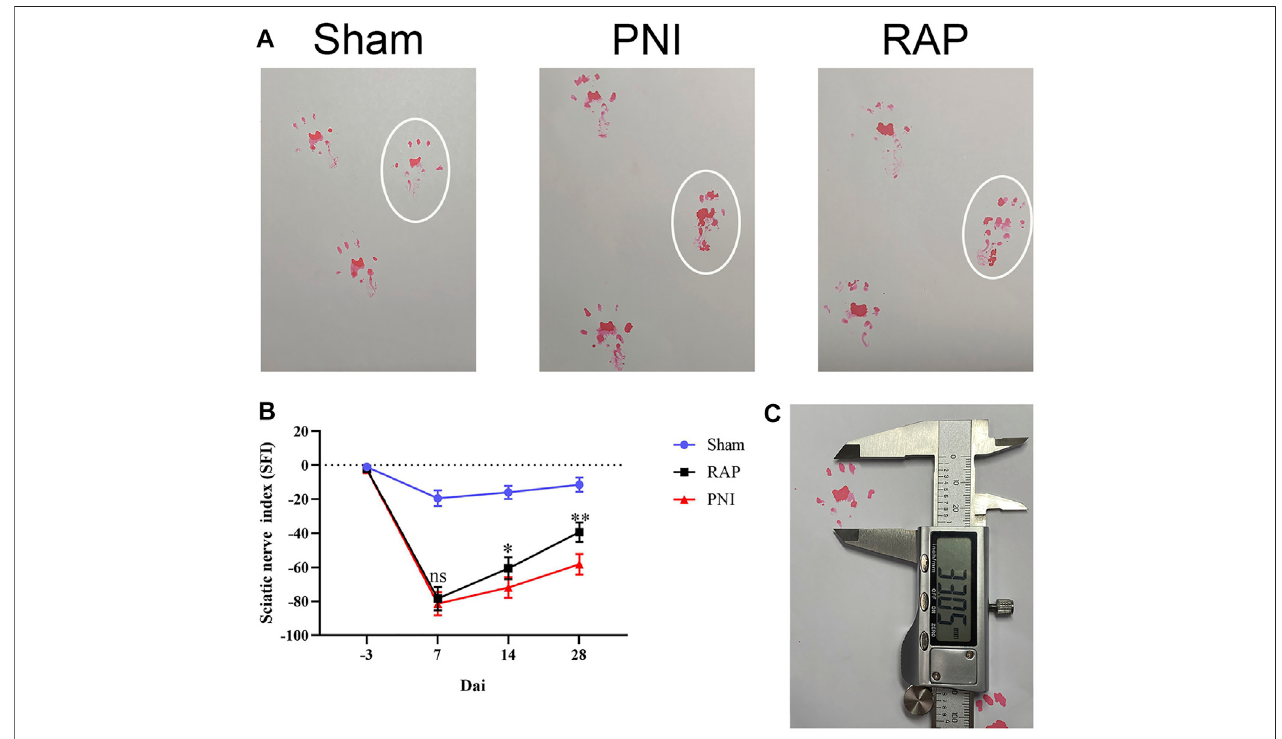
FIGURE 4 | RAP promoted functional recovery after PNI (A) Representative images of footprints of each group of rats 28 days after PNI; white circle shows the footprintsontheinjuredside; (B) Sciaticnervefunctionindex(SFI)analysiswasperformedforeachgroupondays7,14,and28; (C) Representativeimageofthefootprint measurement method. Data are presented as means ± SD. * p < 0.05, ** p <